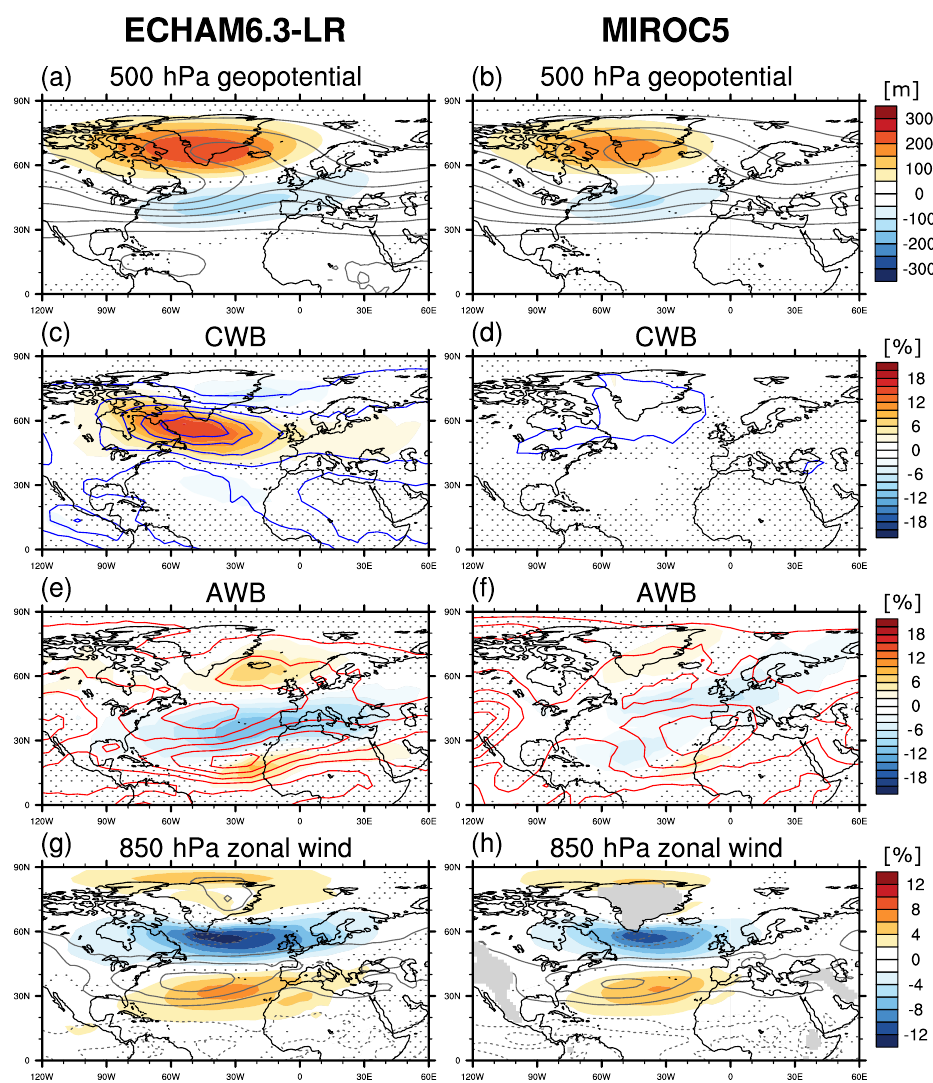
Figure 7. Ensemble means of the circulation anomalies during Greenland blocking days for (left) ECHAM6.3-LR and (right) MIROC5 future experiments. (a, b) 500hPa geopotential (contours are drawn every 100m from 5000 to 6000m) and anomalies (shading, in m). (c, d) Cyclonic wave breaking frequency (first contour and interval: 5%) and anomalies (shading, in %). (e, f) Same as (c) and (d) but for anticyclonic wave breaking frequency. (g, h) Zonal wind at 850hPa (first contour and interval: 4ms − 1 , zero contour omitted, and dashed contours for negative values) and anomalies (shading, in ms − 1 ). Anomalies are deviations from the 10-year DJF climatology, and only members with at least one blocked day are used for the composites. Dotted areas are not significant at the 10% level, with the significance calculated using a bootstrap